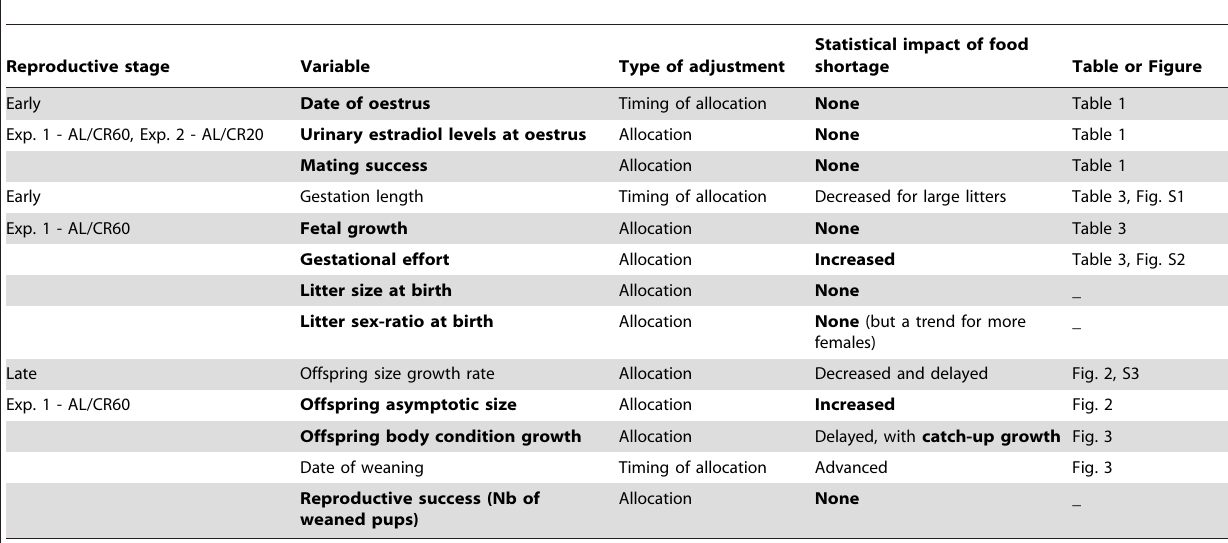
Table 5. Summary table of the effects of food shortage on female reproductive parameters in the present study.